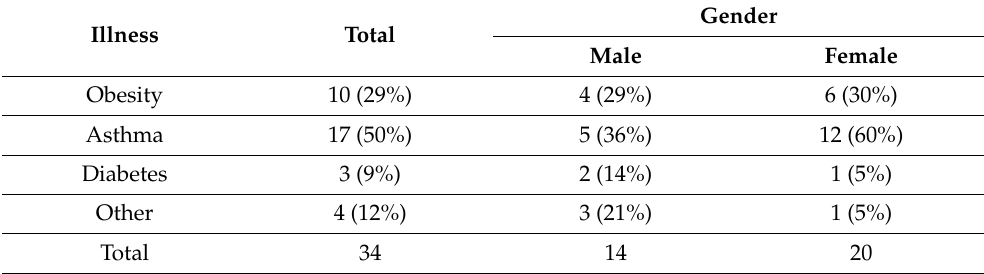
Table 2. Illnesses by